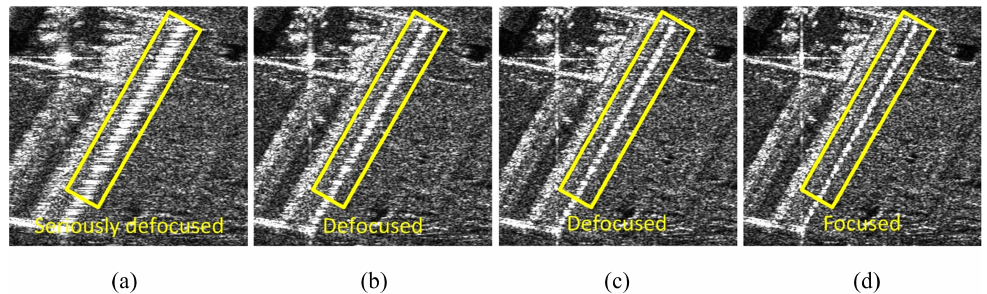
Figure 19. Magnified sub-scene images 1. ( a ) Processed with INS-only MOCO. ( b ) Processed with conventional MDA. ( c ) Processed with RDMDA. ( d ) Processed with 2D-SVMDA.